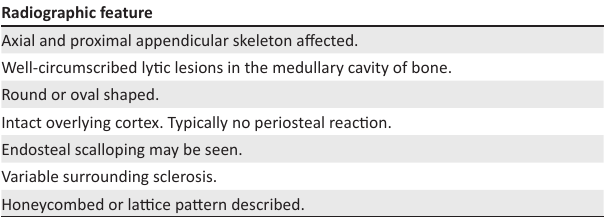
TABLE 2: Differential diagnosis of cystic angiomatosis of bone. More common